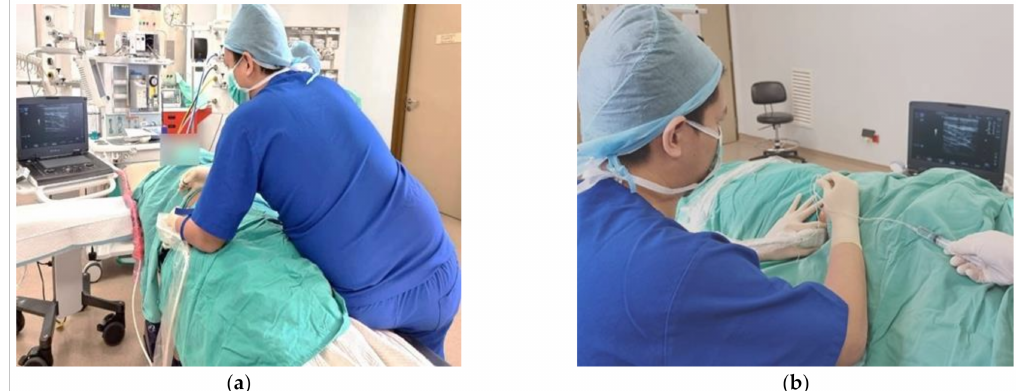
Figure 6. ( a ) Improper position: The operator is positioned with significant trunk bending and twisting. ( b ) Proper position: The operator is sitting down in a neutral position on the side of the block with ultrasound monitor in front, aligned along the visual axis.